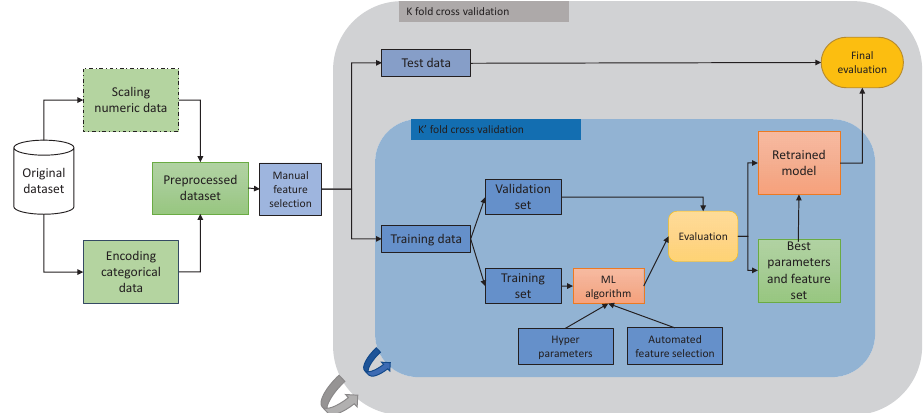
Figure 2. The machine-learning pipeline in more details (symbols with dashed line edges illustrate that that step is not always performed).